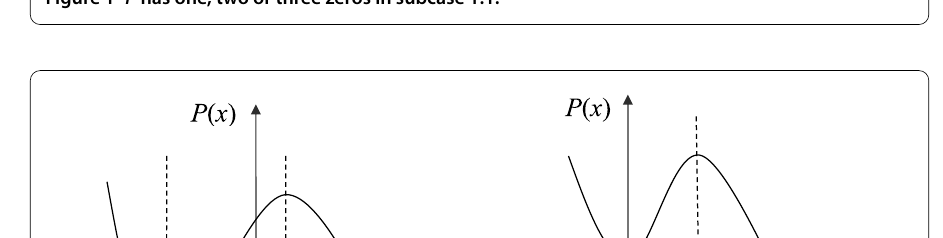
Figure 1 P has one, two or three zeros in subcase